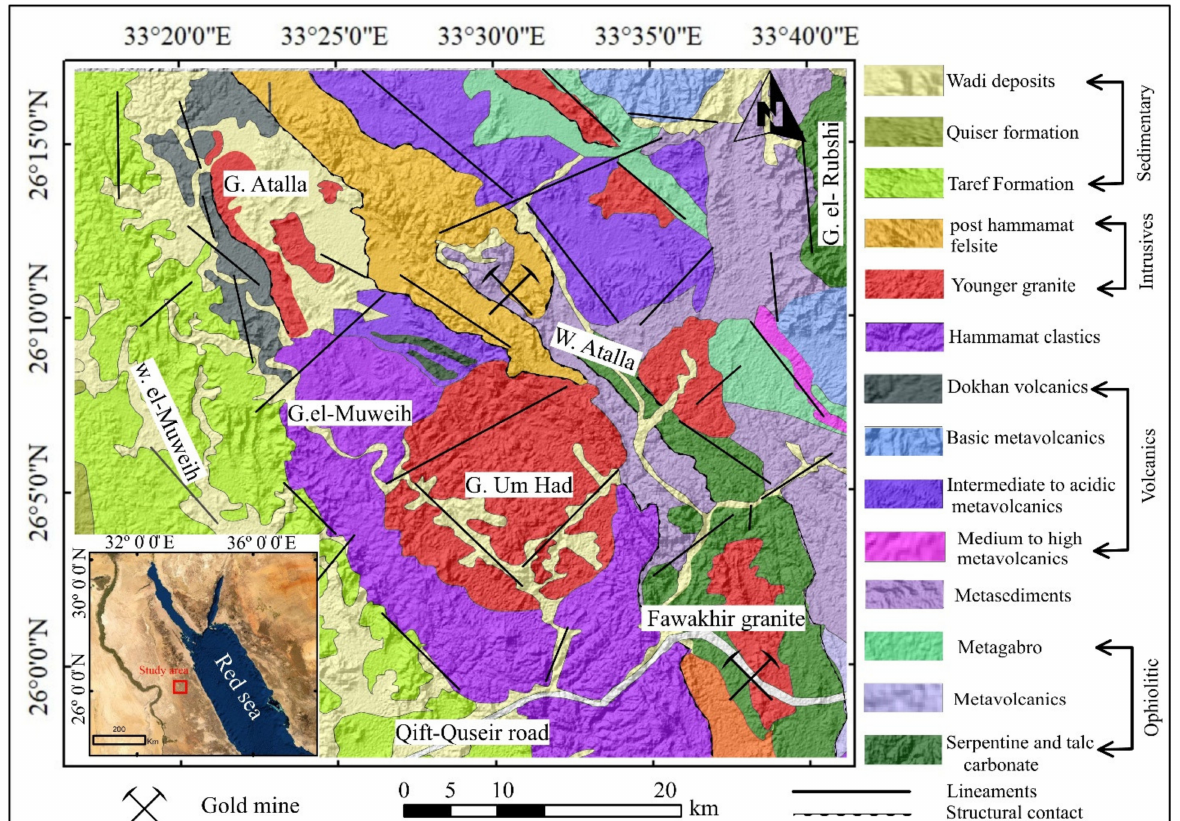
Figure 1. Location and geological map of the study area, (modified after Conoco (1987)